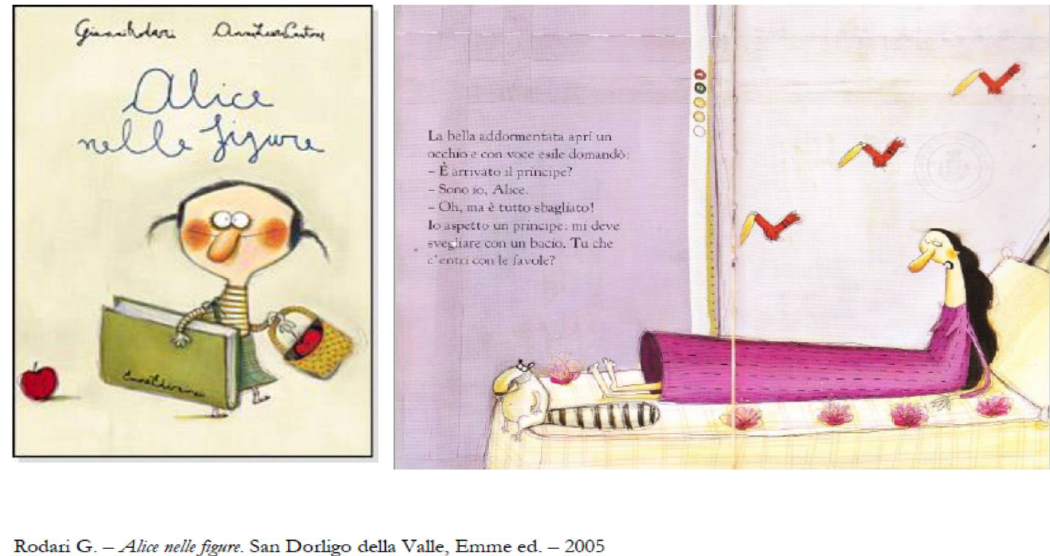
Figure A7. Rodari G.— Alice nelle figure. San Dorligo della valle, Emme ed.—2005.